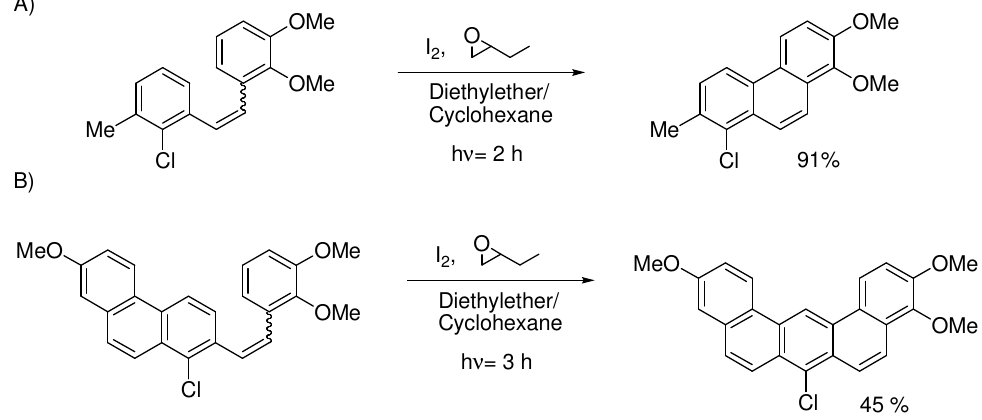
Scheme 13. Examples from ref. [43]. In A) the reaction follows the natural cyclization path but the chloro-group prevents the 50:50 product mixture from meta -methyl. In B) the chloro-groups blocks the preferred cyclization path and forces the product formation.